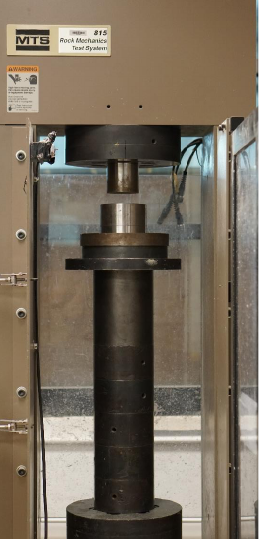
Figure 2. MTS Hydraulic Press at UBC used for the study with the piston and the die